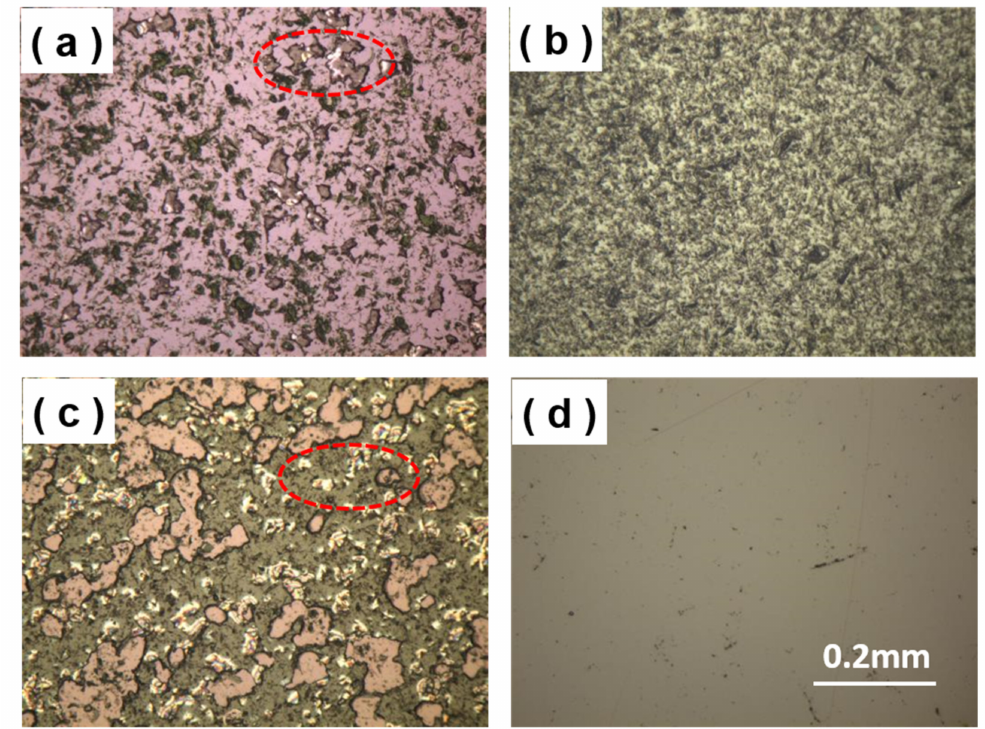
Figure 6. Optical microscope pictures showing ( a ) uncovered ITO films; ITO films covered by ( b ) acrylic-based, ( c ) silicone and ( d ) PU topcoats after sand erosion for 30 min.